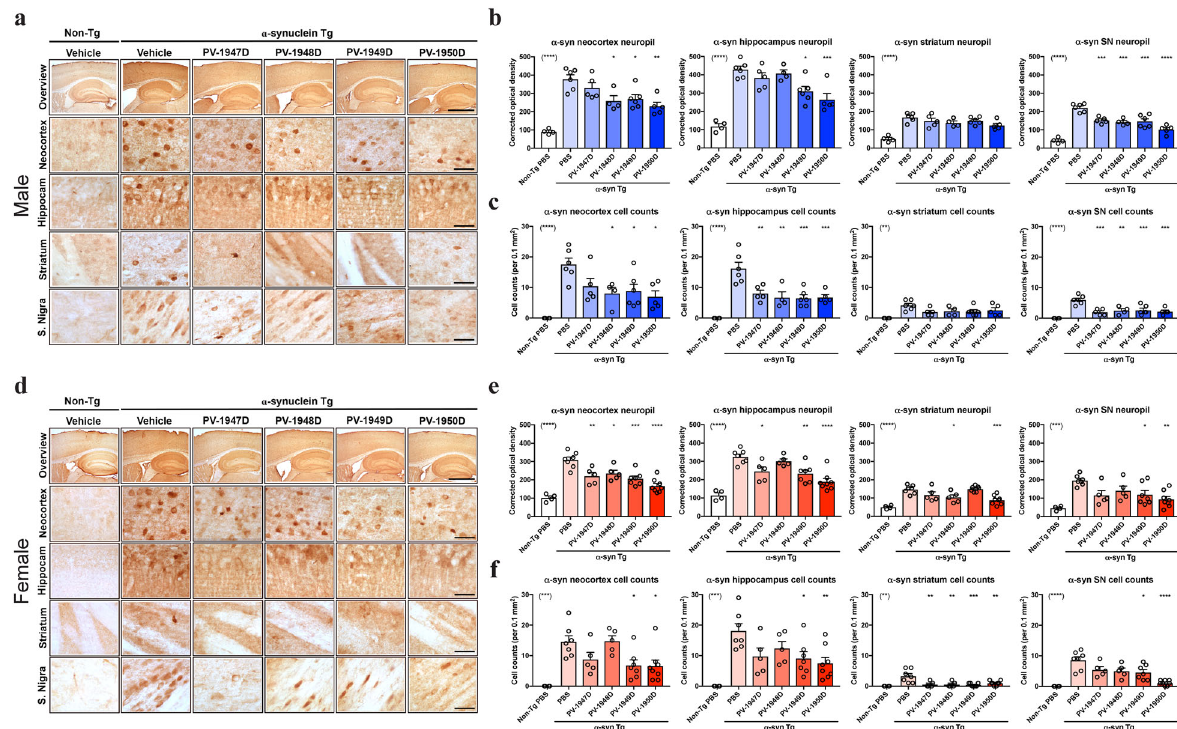
Fig. 3 Vaccination with MultiTEP-based anti- α Syn vaccines signi fi cantly reduced the accumulation of total α -synuclein in D line transgenic mice. a Representative images of male mice brain sections immunostained with the antibody against total α Syn (Syn1) from top to bottom panels include an overview of the brain, neocortex, hippocampus, striatum, and substantia nigra region in non-Tg and h α Syn Tg mouse treated with vehicle, PV-1947D, PV-1948D, PV-1949D, and PV-1950D. b Image analysis of α Syn in the neuropil expressed as mean corrected optical density in the neocortex, hippocampus, striatum, and substantia nigra (from left to right) in male mice. c Image analysis of α Syn-positive cell counts per 0.1 mm 2 in the neocortex, hippocampus, striatum, and substantia nigra (from left to right) in male mice. d Representative images of brain sections from female mice immunostained with the Syn1 antibody, panels from top to bottom illustrate an overview of the brain, neocortex, hippocampus, striatum, and substantia nigra regions in non-Tg, and h α Syn Tg mouse treated with vehicle, PV-1947D, PV-1948D, PV-1949D, and PV-1950D vaccination. e Image analysis of α Syn in the neuropil expressed as mean corrected neuropil optical density in the neocortex, hippocampus, striatum, and substantia nigra (from left to right) in female mice. f Image analysis of α Syn- positive cell counts per 0.1 mm 2 in the neocortex, hippocampus, striatum, and substantia nigra (from left to right) in female mice. The scale bar in the overview is 250 µm, the others are 25 µm. * p < 0.05, ** p < 0.01, *** p < 0.001, **** p <